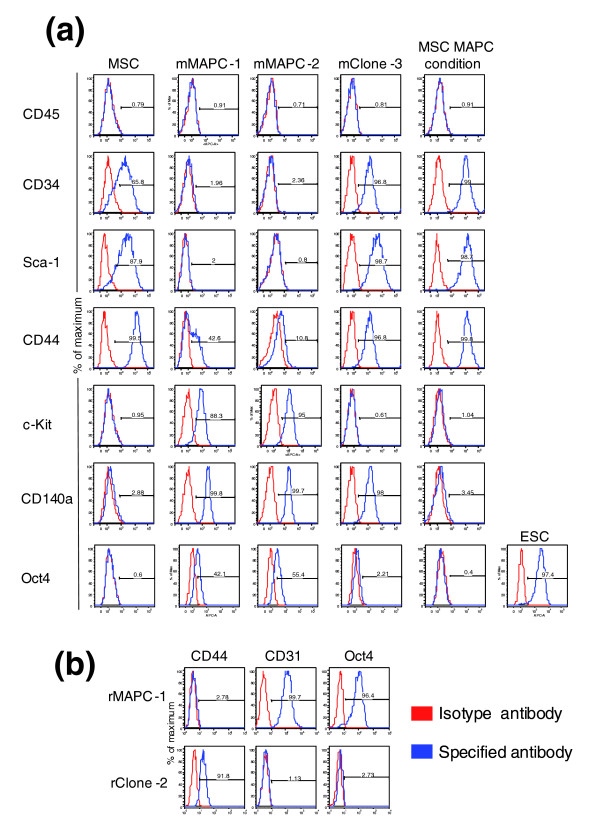
Cell-surface phenotype and Oct4 protein expression of mouse and rat clones evaluated by flow cytometry. (a) Flow cytometry results for mouse clones. From left to right: MSCs; mMAPC-1; mMAPC-2; mClone-3; and MSCs cultured in MAPC conditions. The histogram in each panel plots the number of cells (as a percentage of the maximum) on the vertical axis against the fluorescence intensity of the labeled antibody bound to the indicated protein (horizontal axis). The horizontal line on each histogram indicates the fluorescence range that contains the indicated percentage of cells positive for that protein. (b) Flow cytometry results for the rat clones rMAPC-1 and rClone-2.